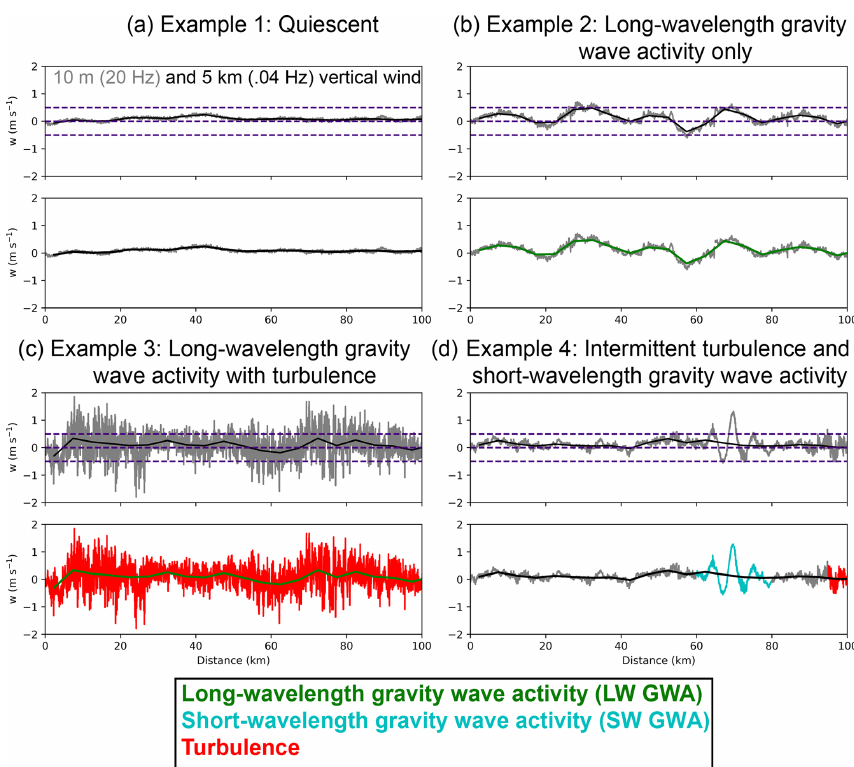
Figure 5. Four example vertical wind time series for 100km long segments from ATTREX 2014 level legs. All plots show the time series of high-rate (20Hz/10m) vertical wind and 5km mean vertical wind ( w 25 ). In the top time series for each example, high-rate vertical wind is in gray and w 25 is in black. Horizontal dashed purple lines indicate 0.0, 0.5, and − 0.5ms − 1 . In the bottom time series for each example, w 25 is colored green if there is long-wavelength gravity wave activity, and the high-rate vertical wind is colored cyan and red where there is short-wavelength gravity wave activity and turbulence,